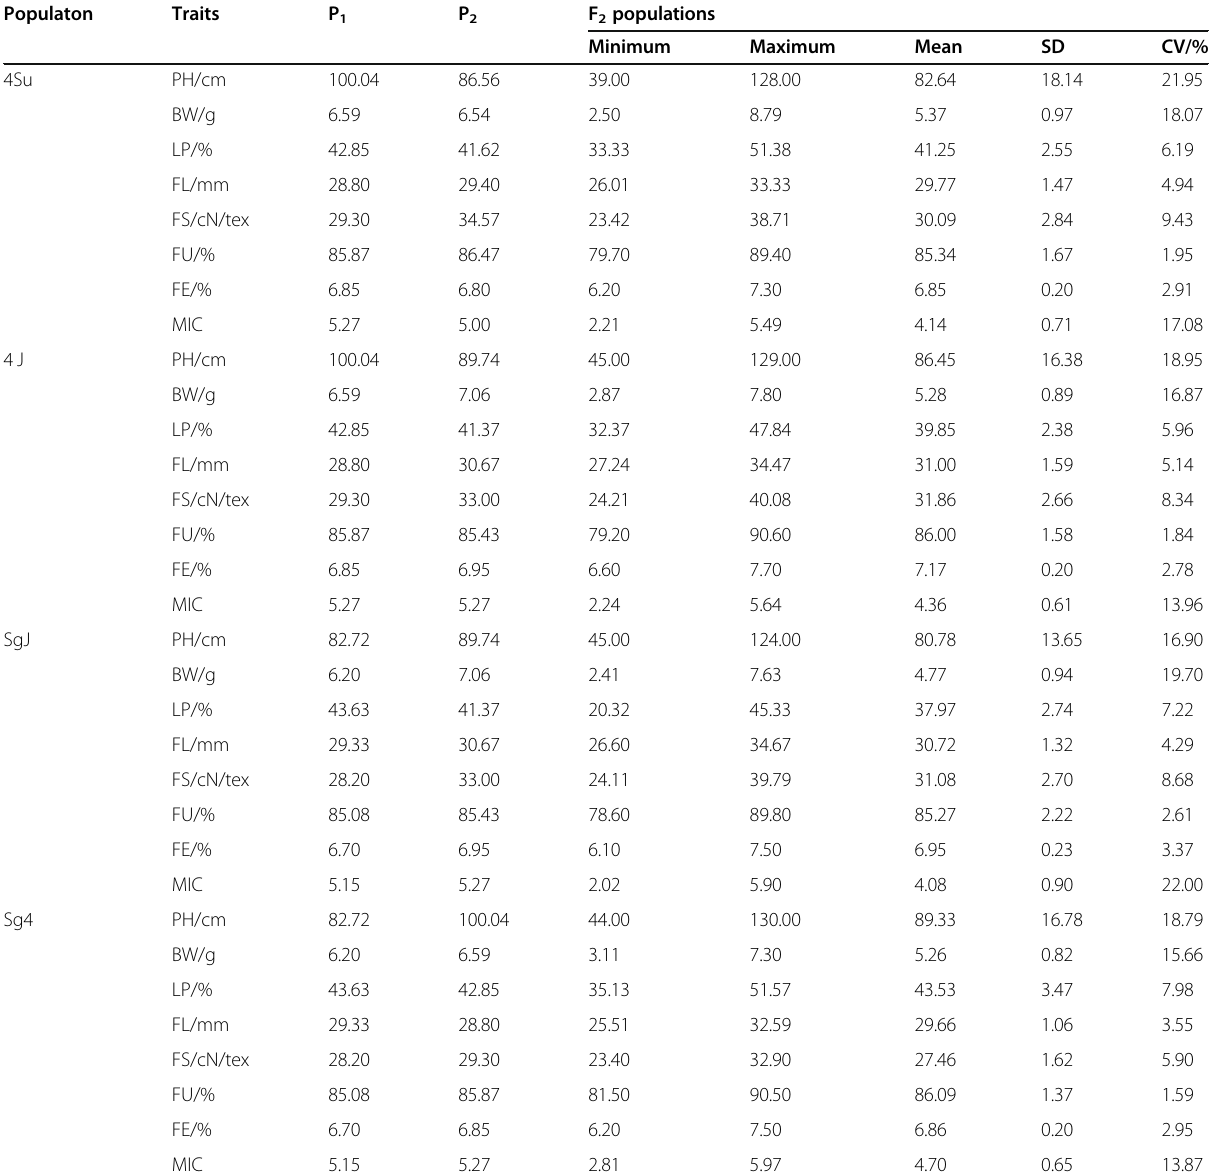
Table 1 Phenotypic variation of 8 traits in four F 2 Populations Populaton Traits P 1 P